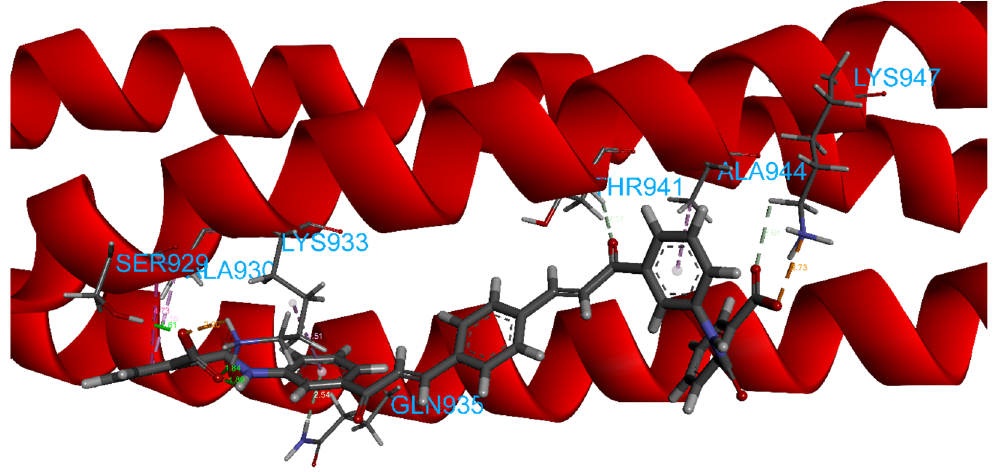
Figure 6. Details of calculated 3D interactions of ZINC00097961973 in complex with SARS-CoV-2’s HR1 domain.